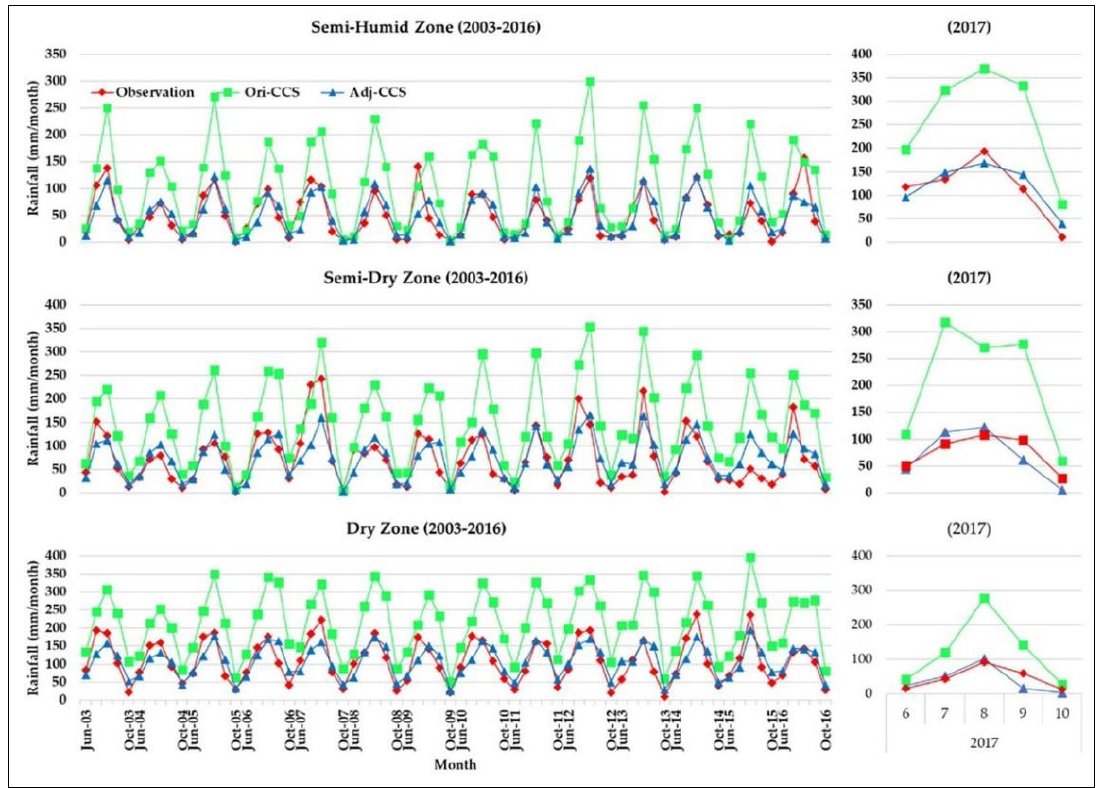
Figure 5. The areal mean monthly rainfall series for gauge observations, Ori-CCS, and Adj-CCS. According to Table 2, the areal mean monthly rainfall estimates of the Ori-CDR evaluation revealed systematic overestimation of biases over the three CZs during the calibration period; the MBs were approximately 18.77 mm/month in the semi-humid zone, 15.99 mm/month in the semi-dry zone, and 16.03 mm/month in the dry zone, and the RMSEs were 28.73 mm/month in the semi-humid zone, 32.44 mm/month in the semi- dry zone, and 25.37 mm/month in the dry zone. The CORRs in these three zones were significantly high, with an average value of 0.91 during the calibration and the validation periods. These CORRs show that the areal mean monthly Ori-CDR rainfall estimates were consistent with the gauge